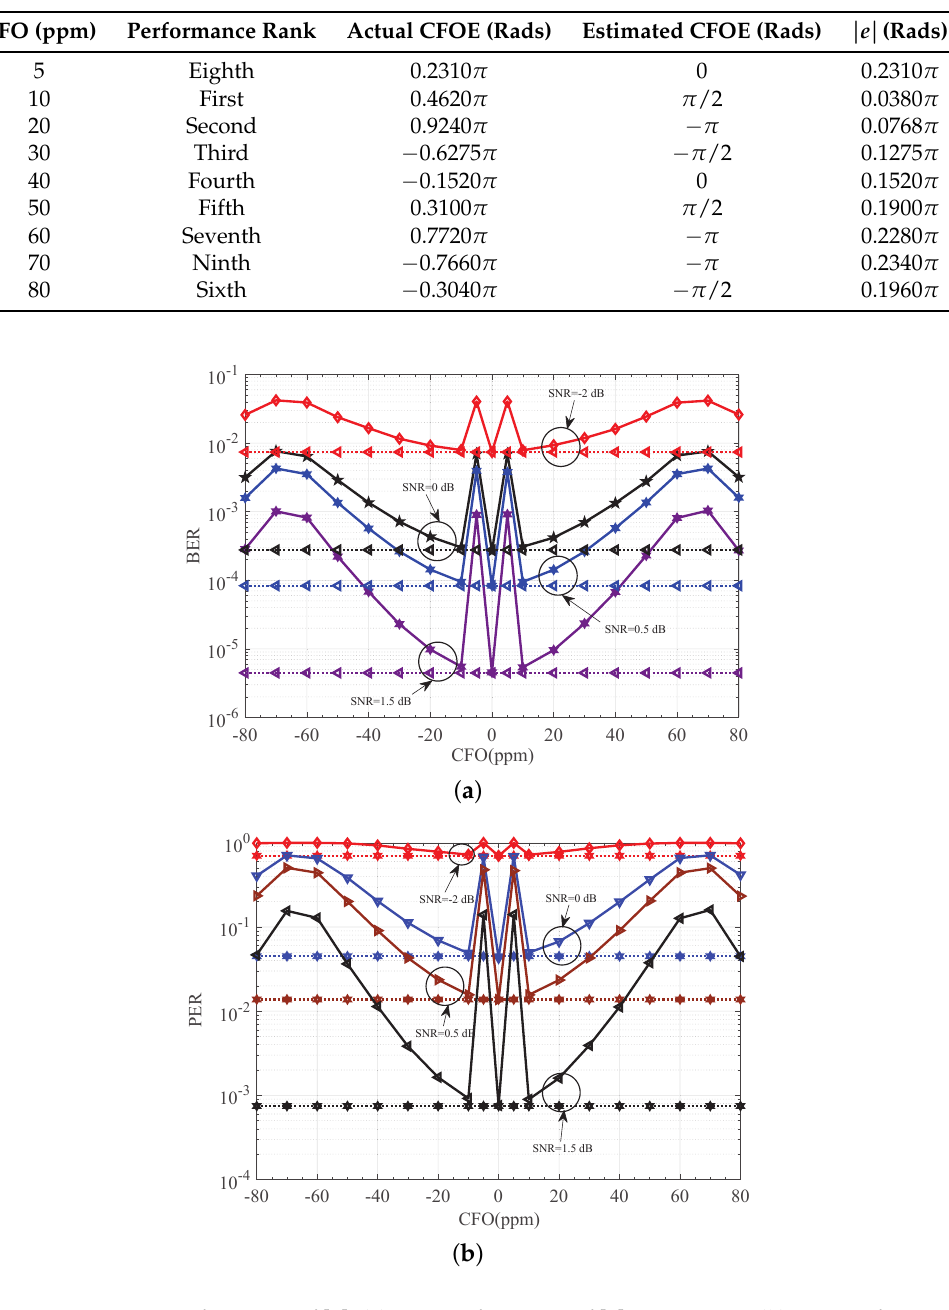
Figure 9. Detection performance of [8]. ( a ) BER performance of [8] versus CFO; ( b ) PER performance of [8] versus CFO. CFO: carrier frequency